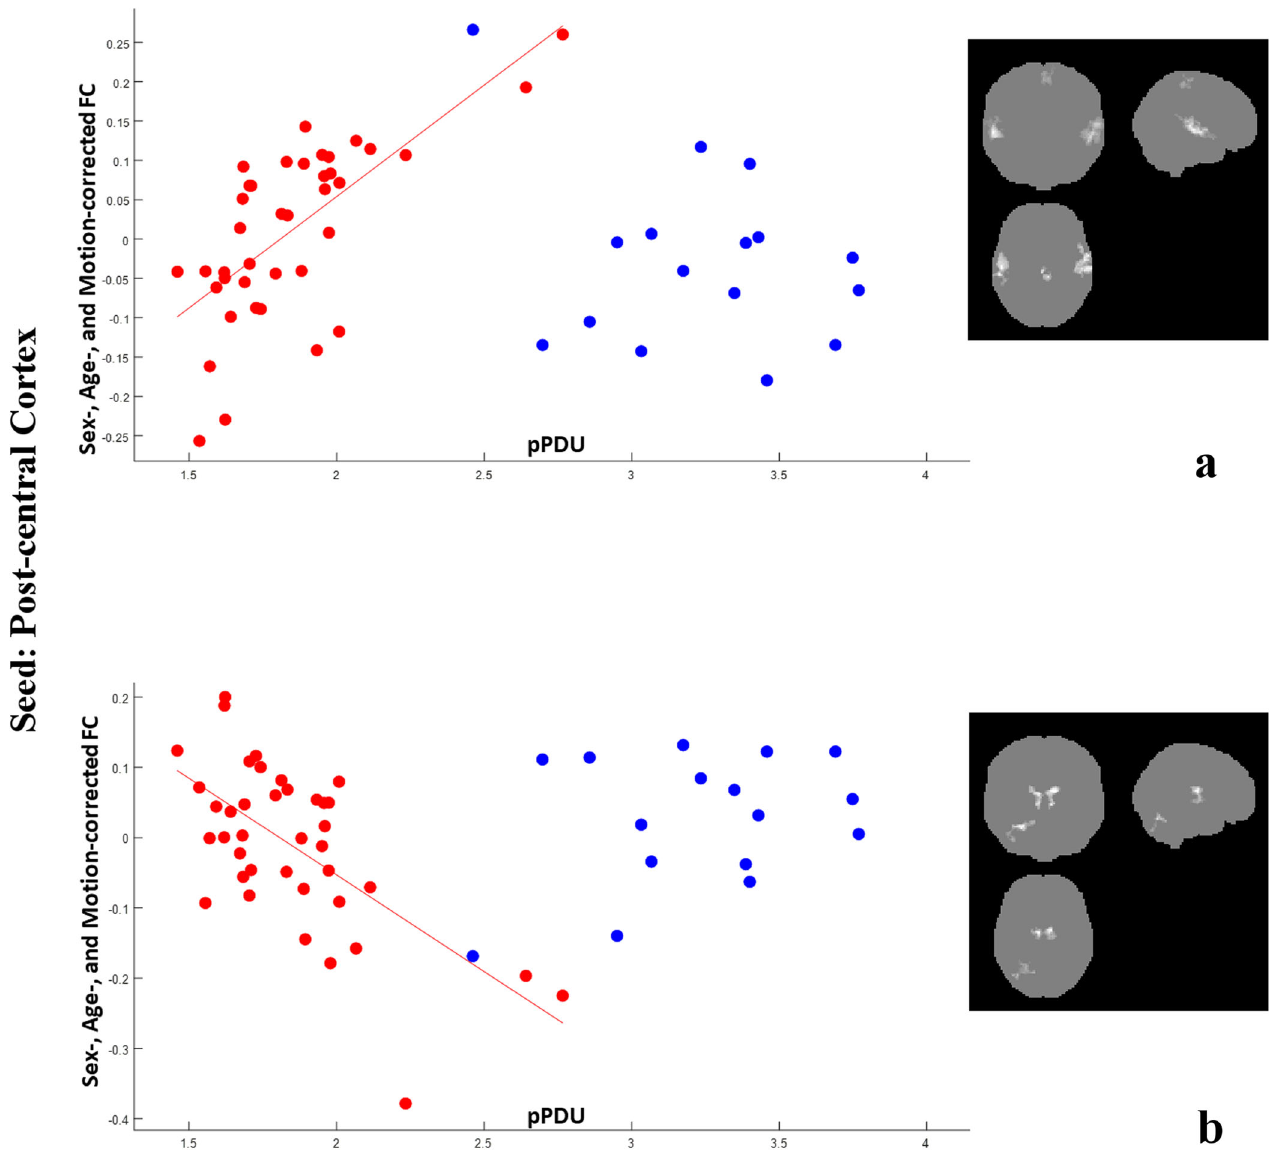
Fig. 2 Correlations of post-central cortex FC with pPDU. Scatterplots for PD (red) and ET (blue) patients of the mean FC of the clusters (highlighted in the inserts on the right, the most affected side is at reader ’ s left) showing a signi fi cant correlation of the post-central cortex FC (y axis) with pPDU ( x axis) in PD patients. For the purposes of the graph, for each contrast all clusters were averaged as they provided substantially overlapping patterns of correlation. The FC of the post-central cortex on the MAS with the superior/mid temporal gyri and the paracentral lobule shows a signi fi cant direct correlation with pPDU in PD patients, with no signi fi cant correlation in ET patients in the same regions ( a ). On the contrary, The FC between the post-central cortex homolateral to the MAS and both thalami and homolateral lobule 6 and crus 1 of the cerebellum decreases with increasing pPDU in PD patients, also in this case without a signi fi cant correlation in ET patients ( b